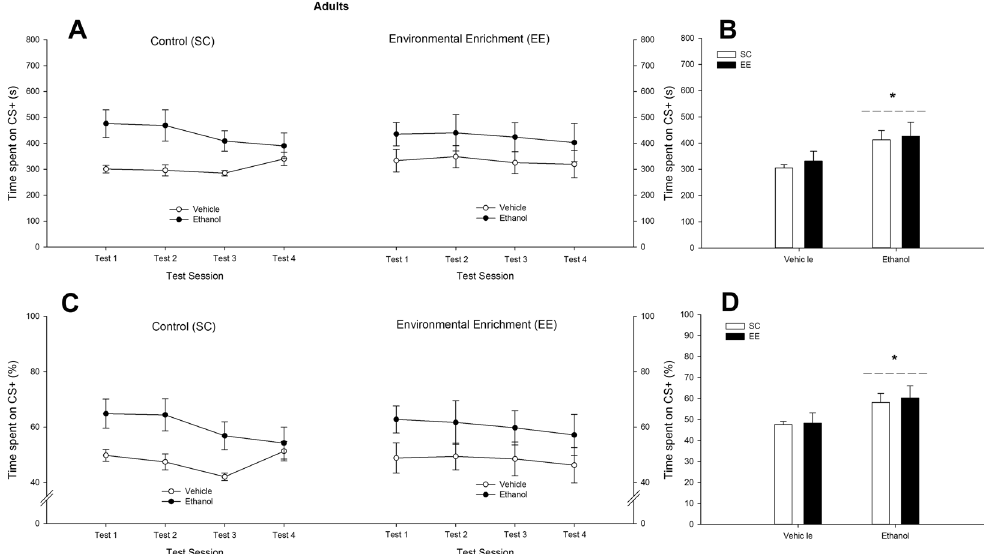
Figure 3. Ethanol-induced conditioned place preference (CPP) of adult male Swiss mice, at test sessions 1, 2, 3 and 4. The line graphs depict time spent (in seconds or in percent preference, sections ( A ) and ( C ), respectively) in the chamber associated with ethanol’s effects (conditioned stimulus [CS + ]), as a function of rearing condition (standard [control] conditions and environmental enrichment; SC and EE groups, respectively) and treatment during CPP training (vehicle or 2.0 g/kg ethanol). The small bar graphs ( B and D ) depict absolute (s) and percent time spent in the CS + collapsed across test sessions. Animals that were given ethanol spent significantly more time in the chamber associated with ethanol than animals that were treated with vehicle, an effect that was statistically similar across test sessions and in EE and SC subjects. This significant effect is indicated by the asterisk sign. Values express mean ± SEM.